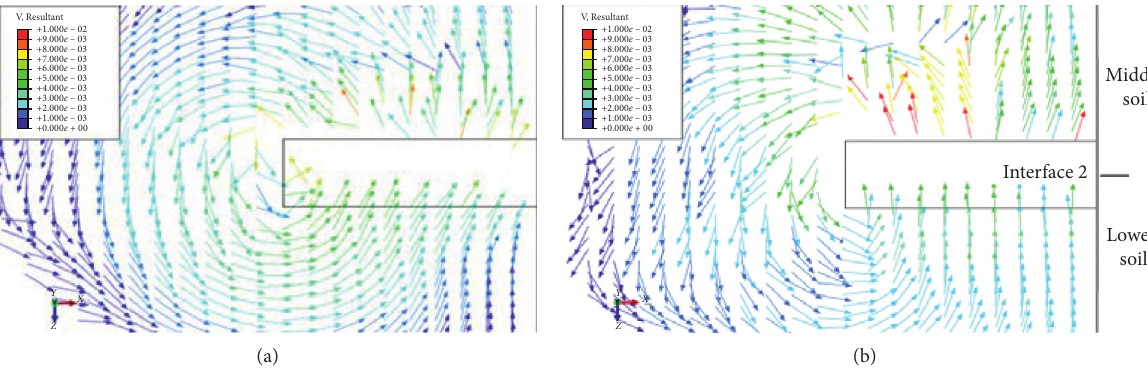
Figure 6: Soil flow under different formation conditions ( H � 12m). (a) Single-layer soil. (b) Layered soils.